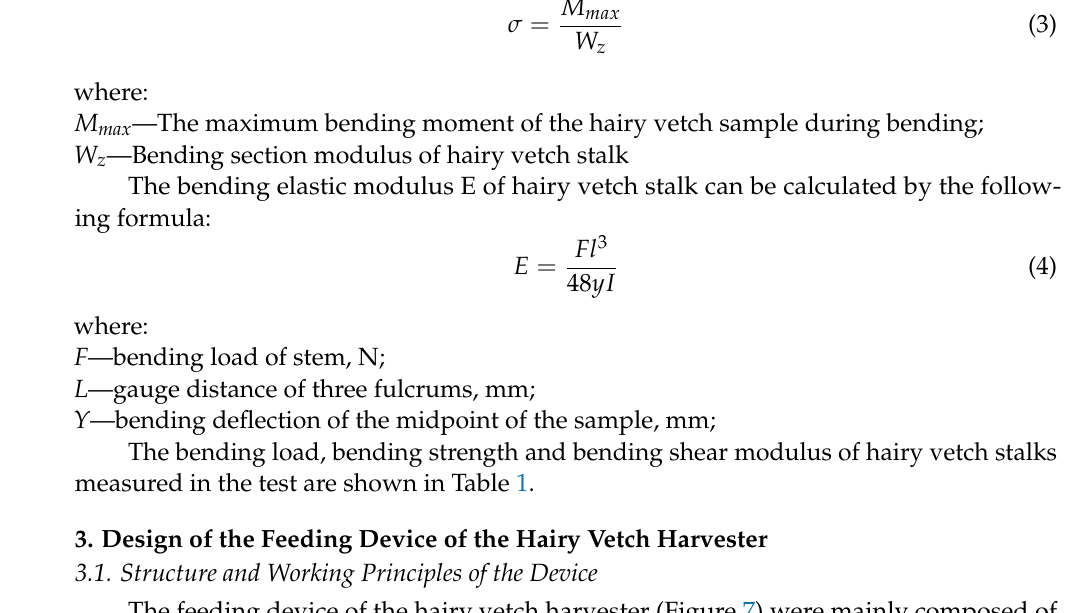
Figure 6. Curve of the stem bending of hairy vetch.